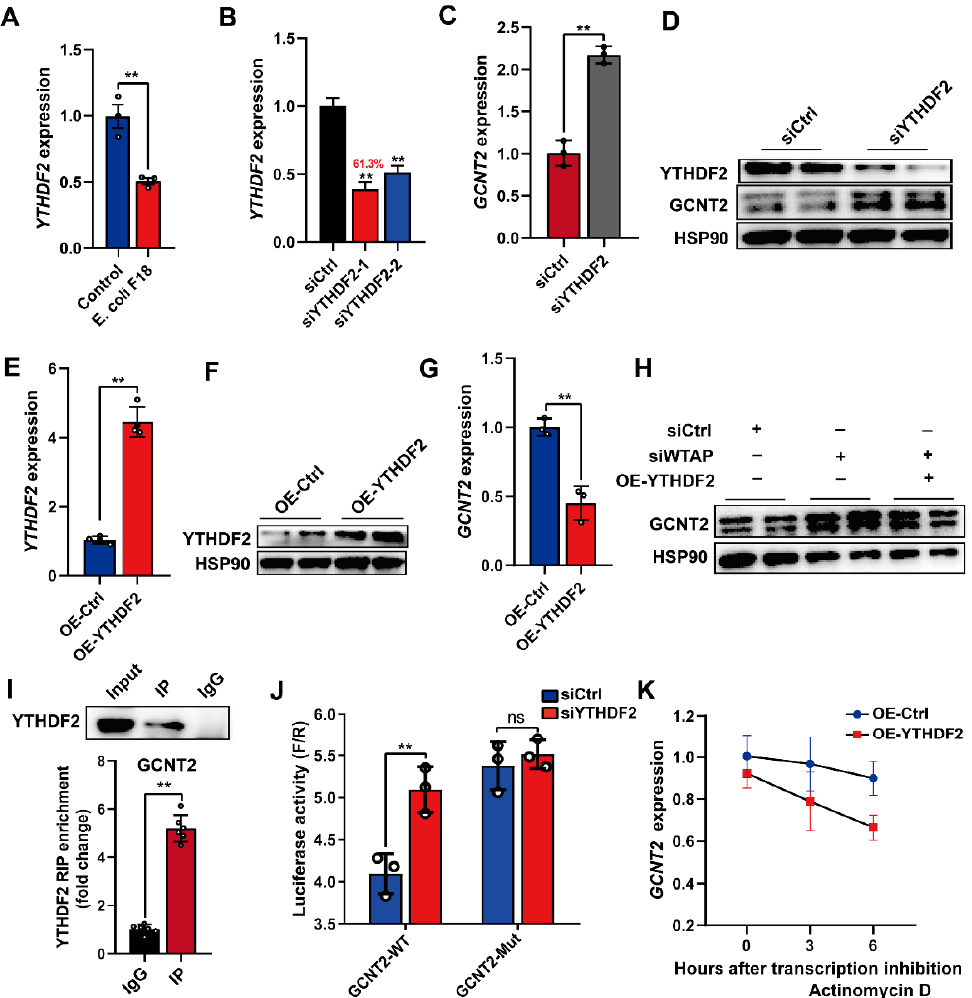
Figure 5. Silencing of WTAP enhanced GCNT2 mRNA stability via YTHDF2-dependent mechanism. ( A ) qPCR detection of YTHDF2 expression in IPEC-J2 cells upon E. coli F18 exposure. ( B ) Knock- down efficiency of YTHDF2 gene in IPEC-J2 was assessed using qPCR. ( C , D ) qPCR and Western blot analysis of GCNT2 expression in control and YTHDF2-knockdown IPEC-J2 cells. ( E , F ) Overex- pression efficiency of YTHDF2 gene in IPEC-J2 cells was determined using qPCR and Western blot- ting. ( G ) qPCR analysis of GCNT2 expression in control and YTHDF2-overexpressed IPEC-J2 cells. ( H ) Western blot analysis of GCNT2 expression in control, WTAP-knockdown, siWTAP + YTHDF2- overexpressed IPEC-J2 cells. ( I ) RIP assays of YTHDF2 association with IKBKG. Nuclear lysates of IPEC-J2 cells were immunoprecipitated with control mouse IgG or anti-histone YTHDF2 antibody, and the enrichment of GCNT2 was analyzed by using qPCR. ( J ) Relative luciferase activity of wild- type (WT) or mutant-type (Mut) GCNT2- 3′UTR luciferase reporter in IPEC -J2 transfected with con- trol or YTHDF2 siRNAs. ( K ) mRNA stability analysis of GCNT2 mRNA in control, YTHDF2-over- expressed IPEC-J2 treated with actinomycin D for 3 and 6 h. All data are presented as the mean ± SD, ** p < 0.01, ns p > 0.05.